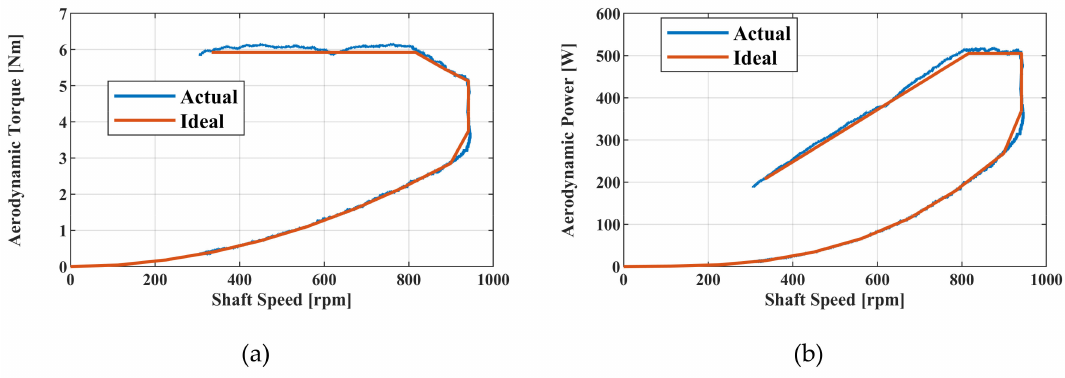
Figure 16. Regulation characteristics comparisons: ( a ) ideal and actual aerodynamic torque depending on shaft speed; ( b ) ideal and actual aerodynamic power depending on shaft